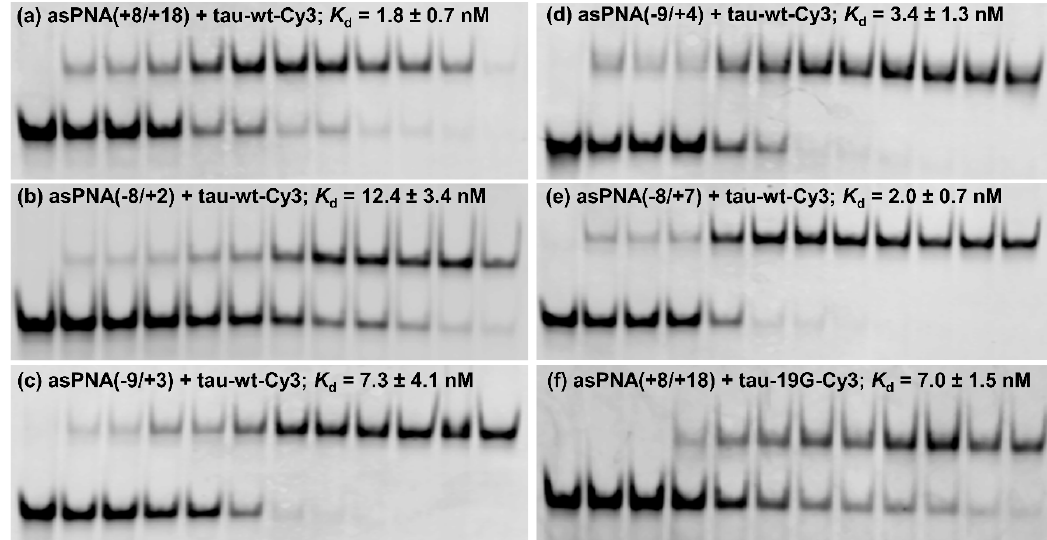
Figure 3. Nondenaturing PAGE study of various asPNAs binding to tau-wt-Cy3 and tau-19G-Cy3 (see Figure 2f,g). The gels contained a running bu ff er of 1 × TBE, pH 8.3, and were run for 5 h at 250 V. The incubation bu ff er was 200 mM NaCl, 0.5 mM EDTA, and 20 mM HEPES at pH 7.5. RNA hairpins were loaded at 5 nM in 20 µ L. The PNA concentrations in the lanes from left to right were 0, 0.5, 1, 2, 5, 10, 15, 20, 30, 50, 100, and 200 nM, respectively. ( a , f ) asPNAs binding to the 3 (cid:48) arm of the splice site hairpins. Compared to tau-WT-Cy3, tau-19G-Cy3 showed weakened binding to asPNA( + 8 /+ 18), even though the C + 19G mutation was adjacent to, but not within, the recognition site of the asPNA (Figure 2), indicating that the single C + 19G mutation stabilized the splice site hairpin. ( b – e ) asPNAs binding to the 5 (cid:48) arm of the splice site